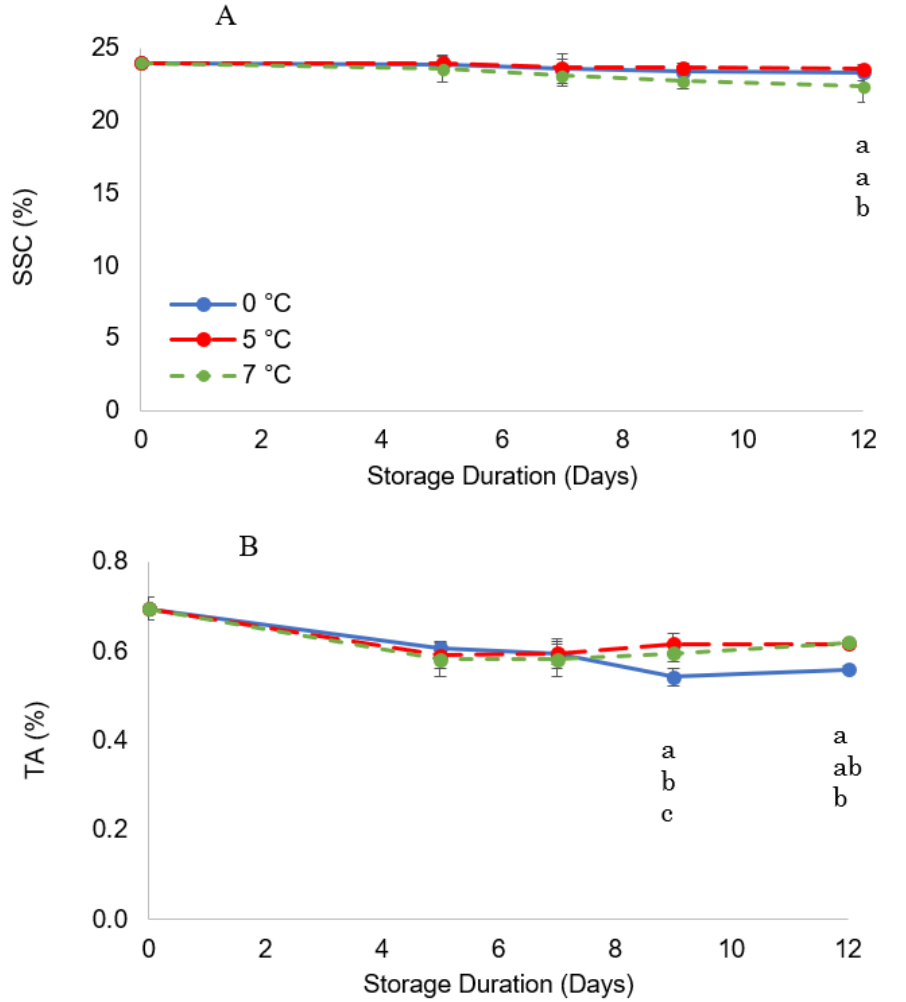
Figure 5. Change in soluble solid content (SSC) ( A ) and titratable acidity (TA) ( B ) during storage. Values marked with the same letter on the same sampling day are not significantly different, according to a Tukey’s test ( p < 0.05).